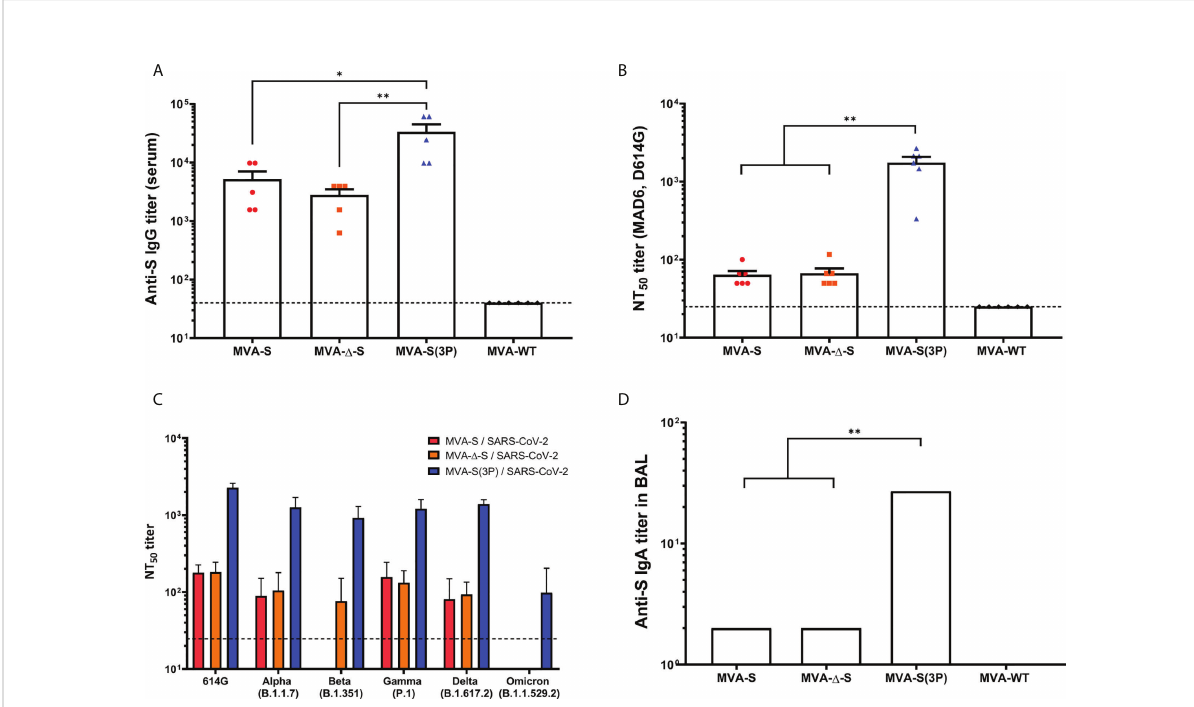
FIGURE 1 SARS-CoV-2-speci fi c humoral immune responses elicited in C57BL/6 mice immunized with one IN dose of different MVA-based vaccine candidates against COVID-19. SARS-CoV-2-speci fi c humoral immune responses were evaluated in serum and BAL samples obtained at 14 days postimmunization from C57BL/6 mice immunized with one IN dose of MVA-S, MVA- D -S, or MVA-S(3P). (A) Titers of binding IgG antibodies speci fi c for the S protein (Wuhan strain), determined by ELISA in individual mouse serum samples in duplicate. Mean values and SEM are represented. The dashed line represents the limit of detection. (B) SARS-CoV-2 neutralizing antibody titers. NT 50 titers were determined in individual mouse serum samples by using a live virus microneutralization assay. Mean NT 50 values and SEM are represented. The dashed line represents the limit of detection (1:25 dilution). (C) SARS-CoV-2 neutralizing antibody titers against SARS-CoV-2 VoC. NT 50 titers were evaluated in pooled mouse serum samples, using VSV-based pseudoparticles expressing the SARS-CoV-2 S protein of different VoC. Mean NT 50 values and 95% con fi dence intervals are represented. The dashed line represents the limit of detection. (D) Titers of IgA antibodies speci fi c for the S protein (Wuhan strain), determined by ELISA in pooled BAL samples in duplicate. Mean values and SEM are represented. Student ’ s t -test: * p < 0.05; ** p <